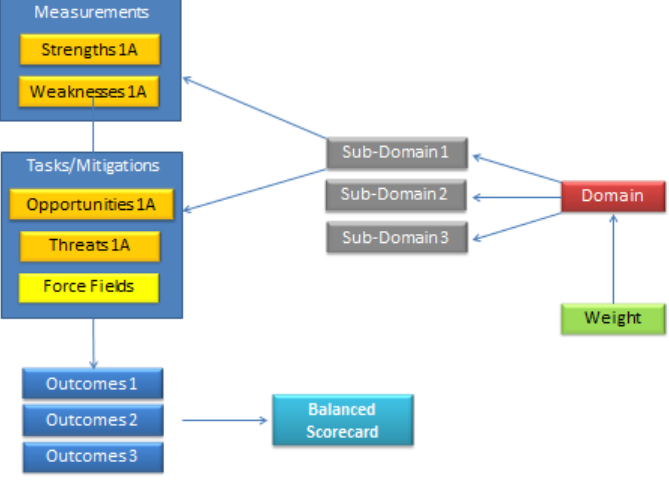
Figure 3. Domain Figure 2. Domain taxonomy.